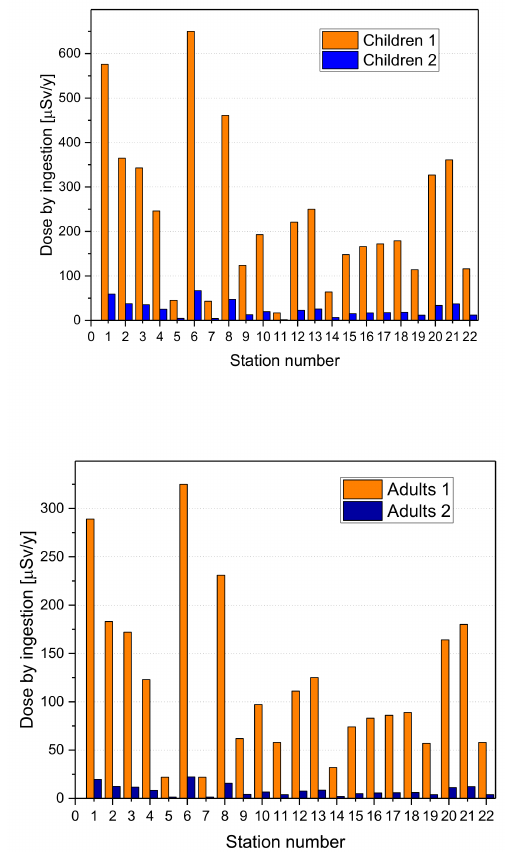
Figure 6. Annual e ff ective dose due to ingestion for adults and children, calculated with a water consumption of 730 L / y (ADULTS1 and CHILDREN1) and with a water consumption of 75 l and 50 l for children and adults respectively according the UNSCEAR2000 (ADULTS2 and